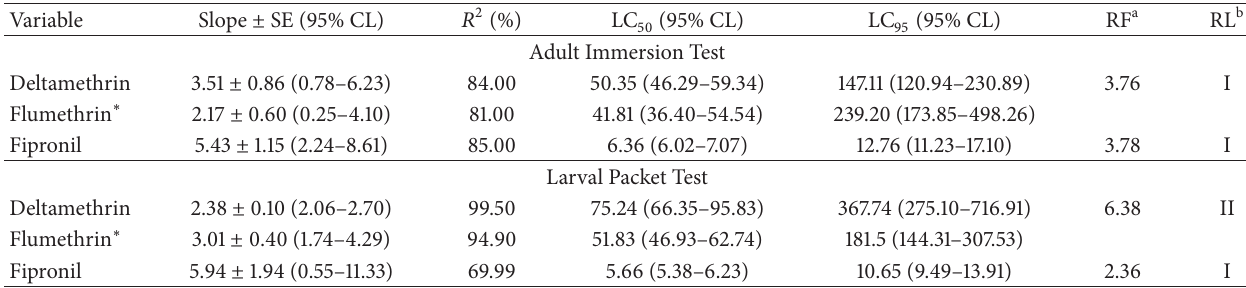
Table 2: Mortality slope, LC 50 and LC 95 confidence limit, resistance factor, and resistance level against deltamethrin, flumethrin, and fipronil as determined by AIT and LPT of ticks collected from North Gujarat,